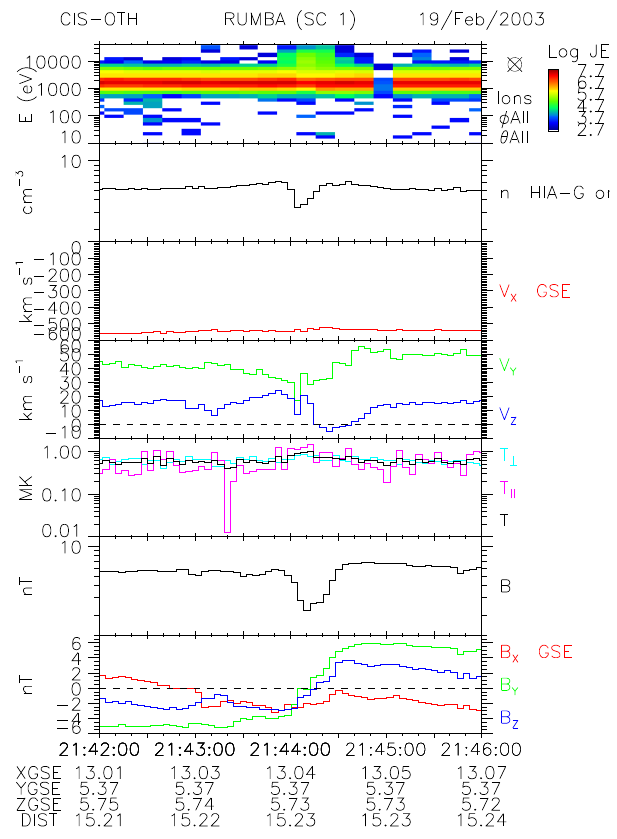
Fig.8. Fig. 8. 19 February 2003 21:42–21:46UT summary plot. Same format as for Fig. 1.